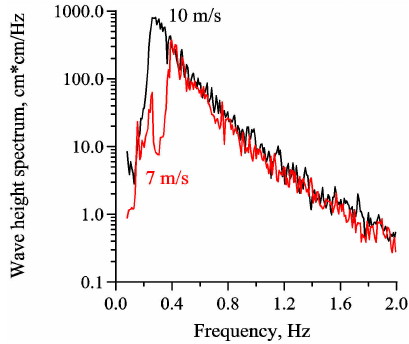
Figure 2. Wave height frequency spectrum at 7 m/s (red) and 10 m/s (black).